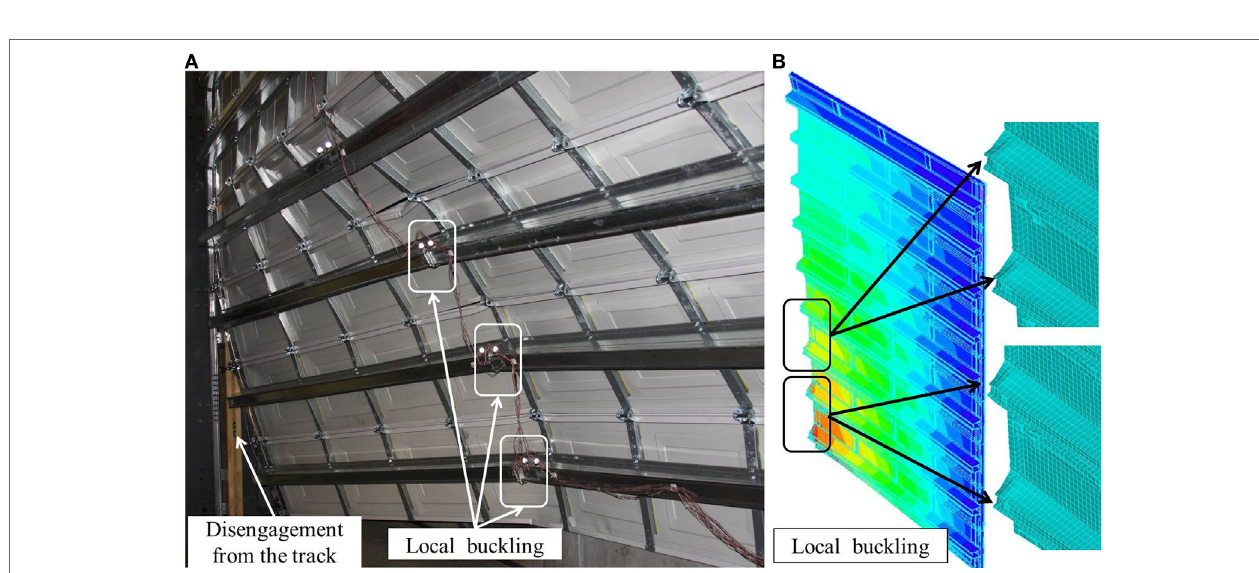
FigUre 11 | catastrophic failure of Door 2: (a) in experimental testing—buckling followed by disengagement from the track and (B) in finite element analysis—analysis that ends when buckling occurs